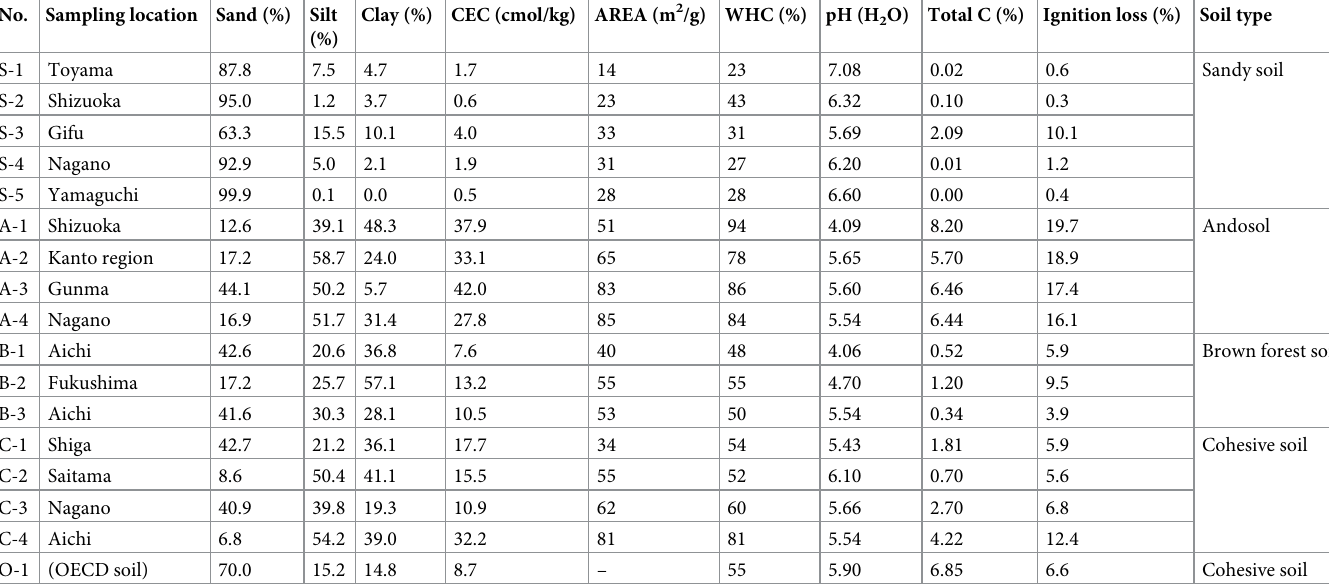
Table 1. Physical and chemical properties of sample